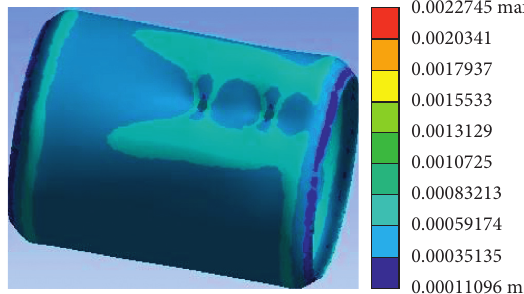
Figure 9: Equivalent strain cloud diagram of the